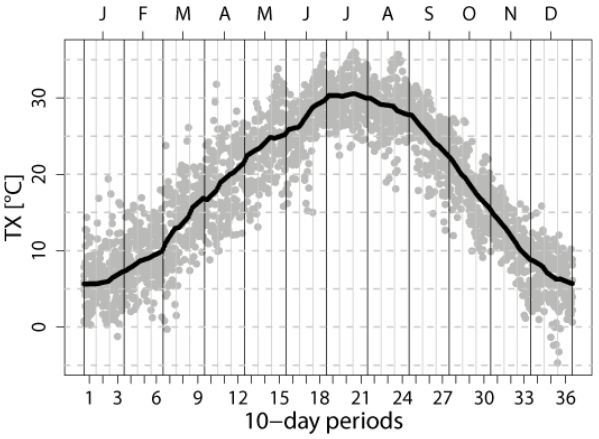
Figure 1. Milan grid point. Location parameter estimates for the calendar year: TX values for the period 2005–2011 in grey; h TX i in black.